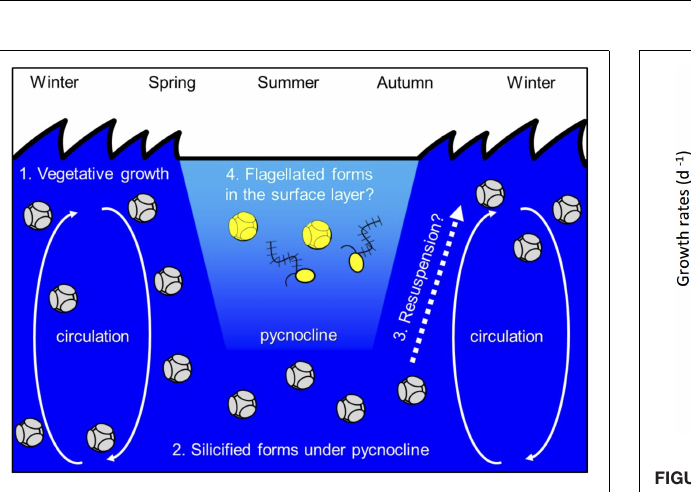
FIGURE 9 | A proposed life history of T. laevis (see text for details).